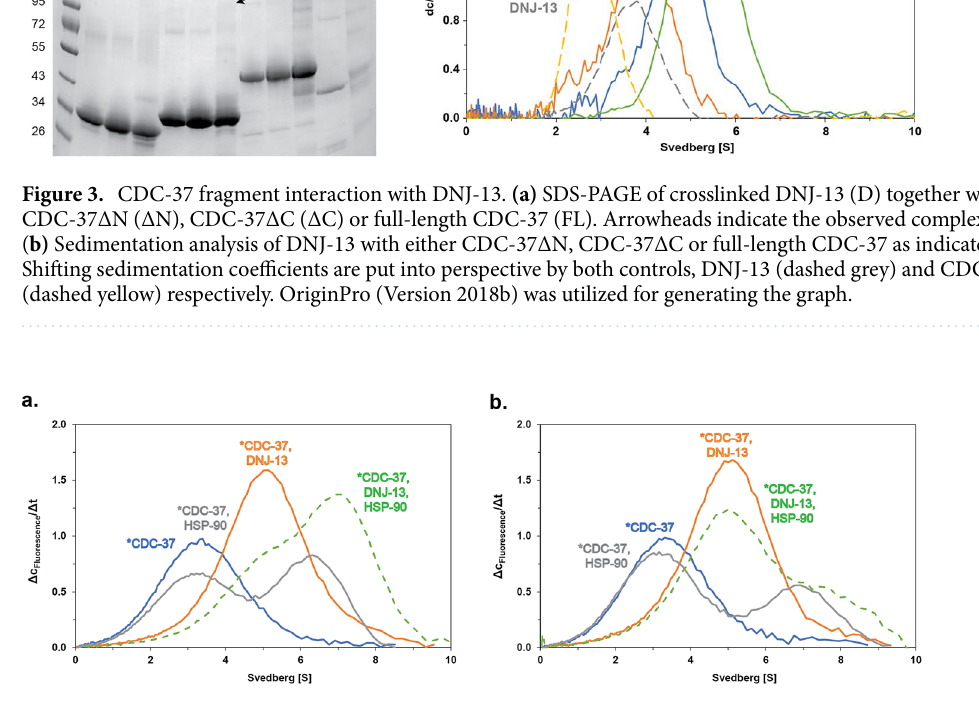
Figure 4. Interaction of HSP-90 with the CDC-37·DNJ-13 complex. (a) Sedimentation analysis of the binary complex, consisting of the either *CDC-37 and DNJ-13 (orange), *CDC-37 and HSP-90 (grey) or the ternary CDC-37·DNJ-13·HSP-90 complex (dashed green). ( b) Effect of ATPγS addition to both binary and ternary complex, similar to (a) . Graphs were generated in OriginPro (Version